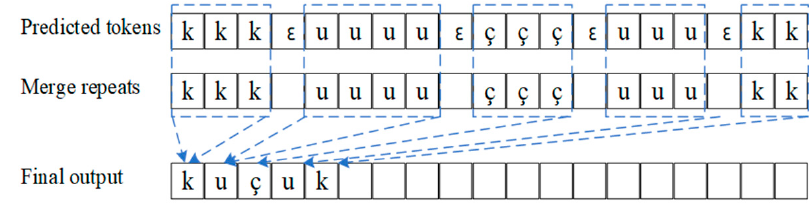
Figure 4. the CTC networks for speech recognition. ε represents a blank symbol.